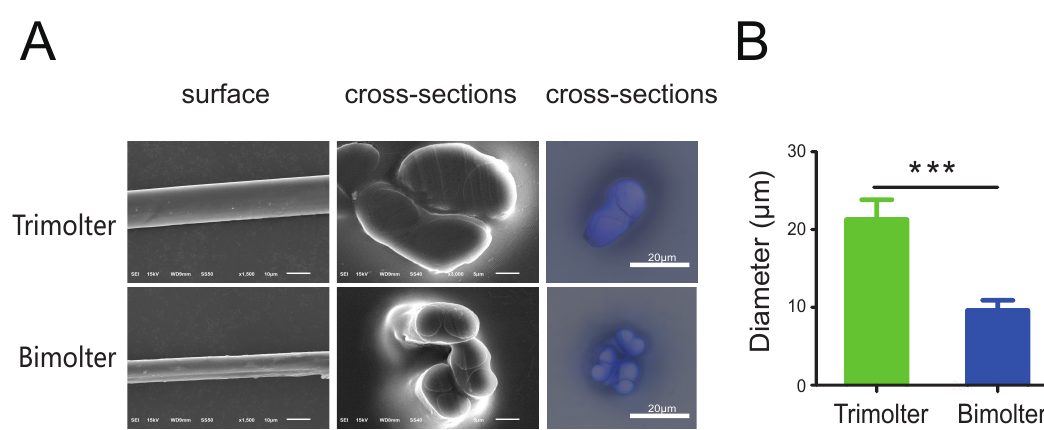
Figure 4. Silk morphologies and diameter. Cocoon silk from the trimolter applied KK-42 and acetone separately on the day-1 of 3rd. ( A ) Surface and cross-sections morphologies of silk were photographed by SEM and optical microscope. Bars represent 10 µ m and 5 µ m respectively. ( B ) The averaged diameter of trimolter and bimolter silk fibers, n = 25. Bars represent 10 µ m. *** represents p < 0.001 (Student’s t -test). Error bars,